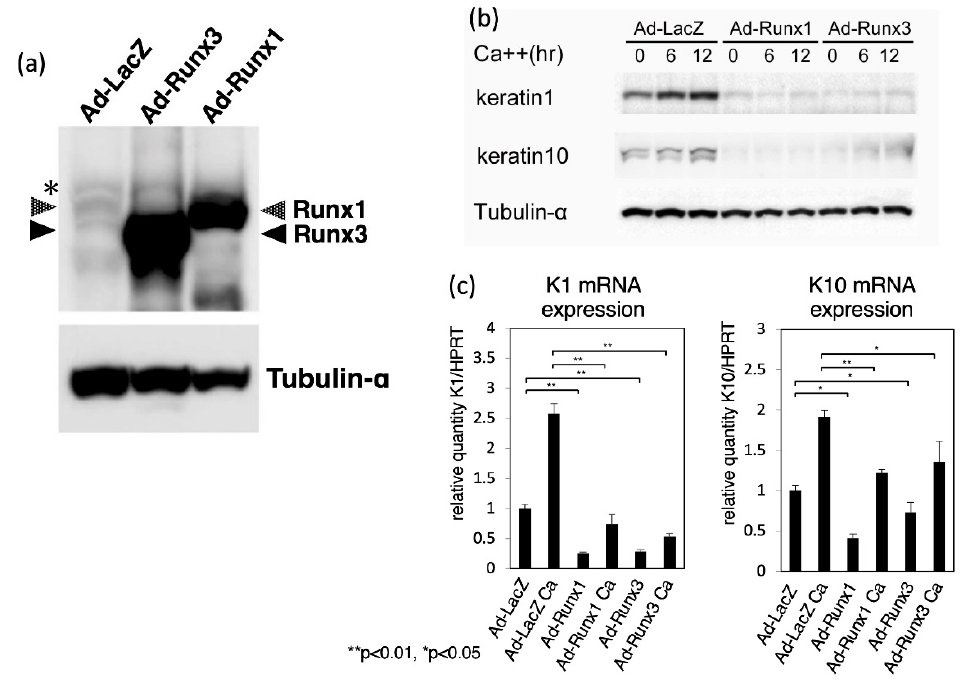
Figure 3. Effects of Runx1/Runx3 overexpression on keratin 1 / keratin 10 transcript and protein